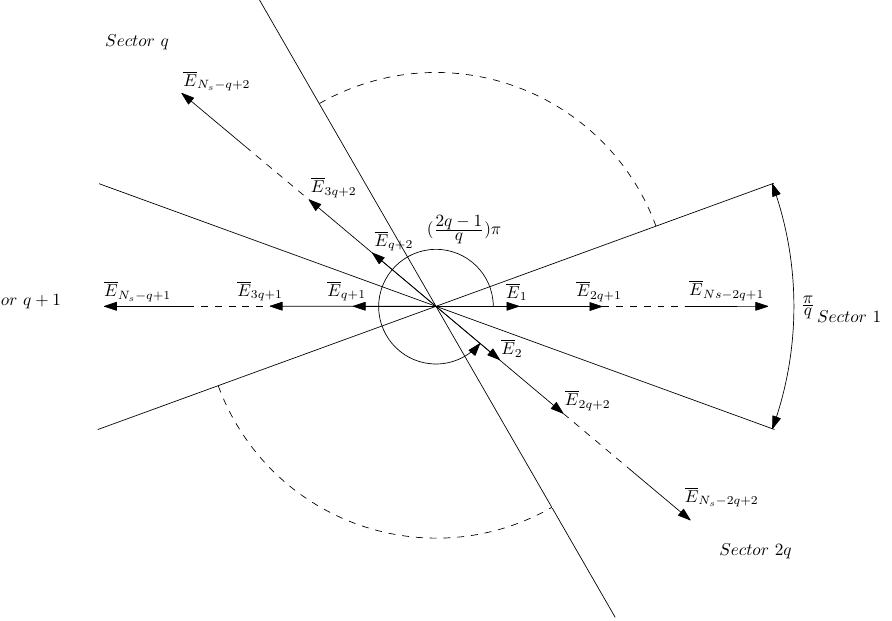
Figure 2. Star of slots of FSPMSMs with an odd number of phases arranged in double-layer slots in the case where the phasors of the back-EMFs induced in the coils of a given phase are colinearly equally distributed in the two opposite sectors assigned to the